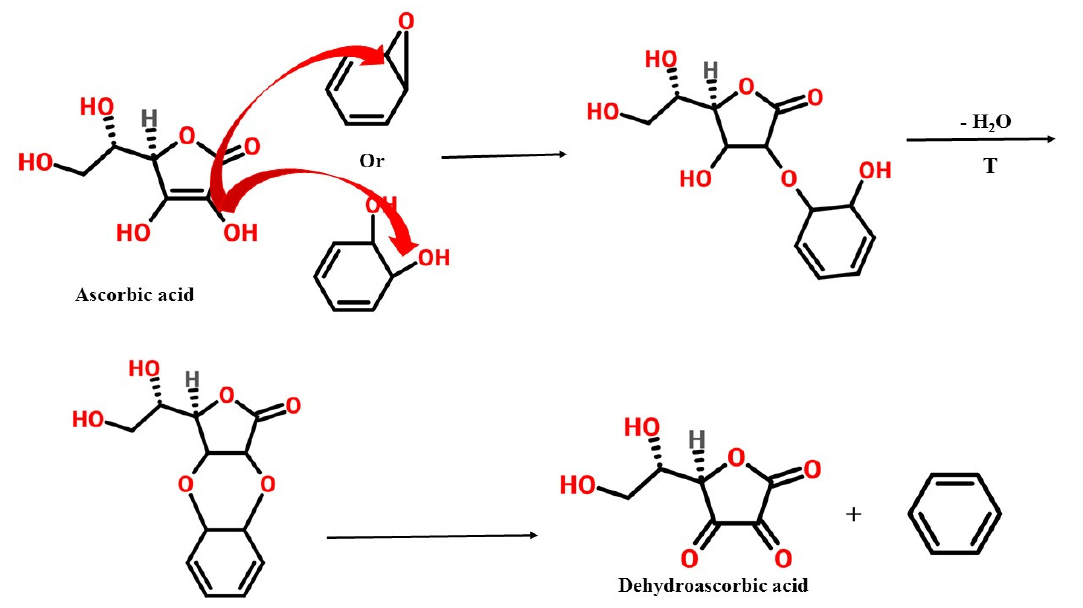
Fig. 5. Proposed mechanisms for the reduction of epoxide and hydroxyl groups with ascorbic